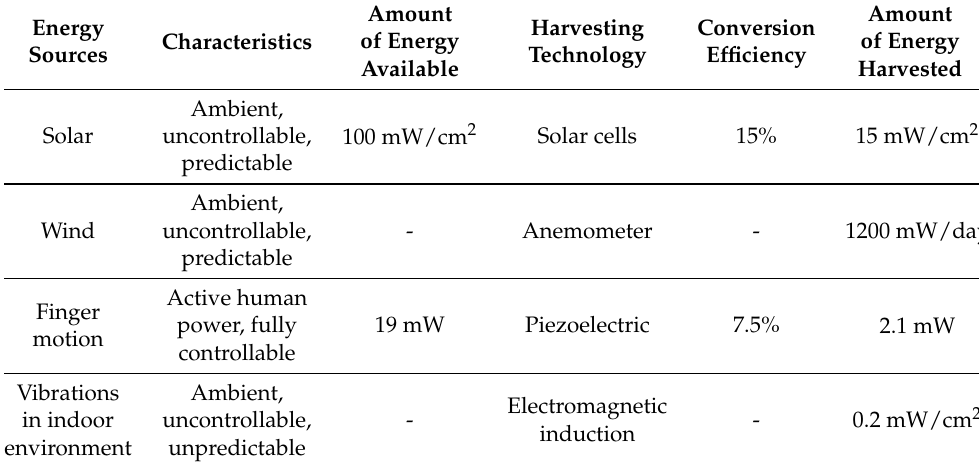
Table 1. Characteristics of various environmental energy sources [9].